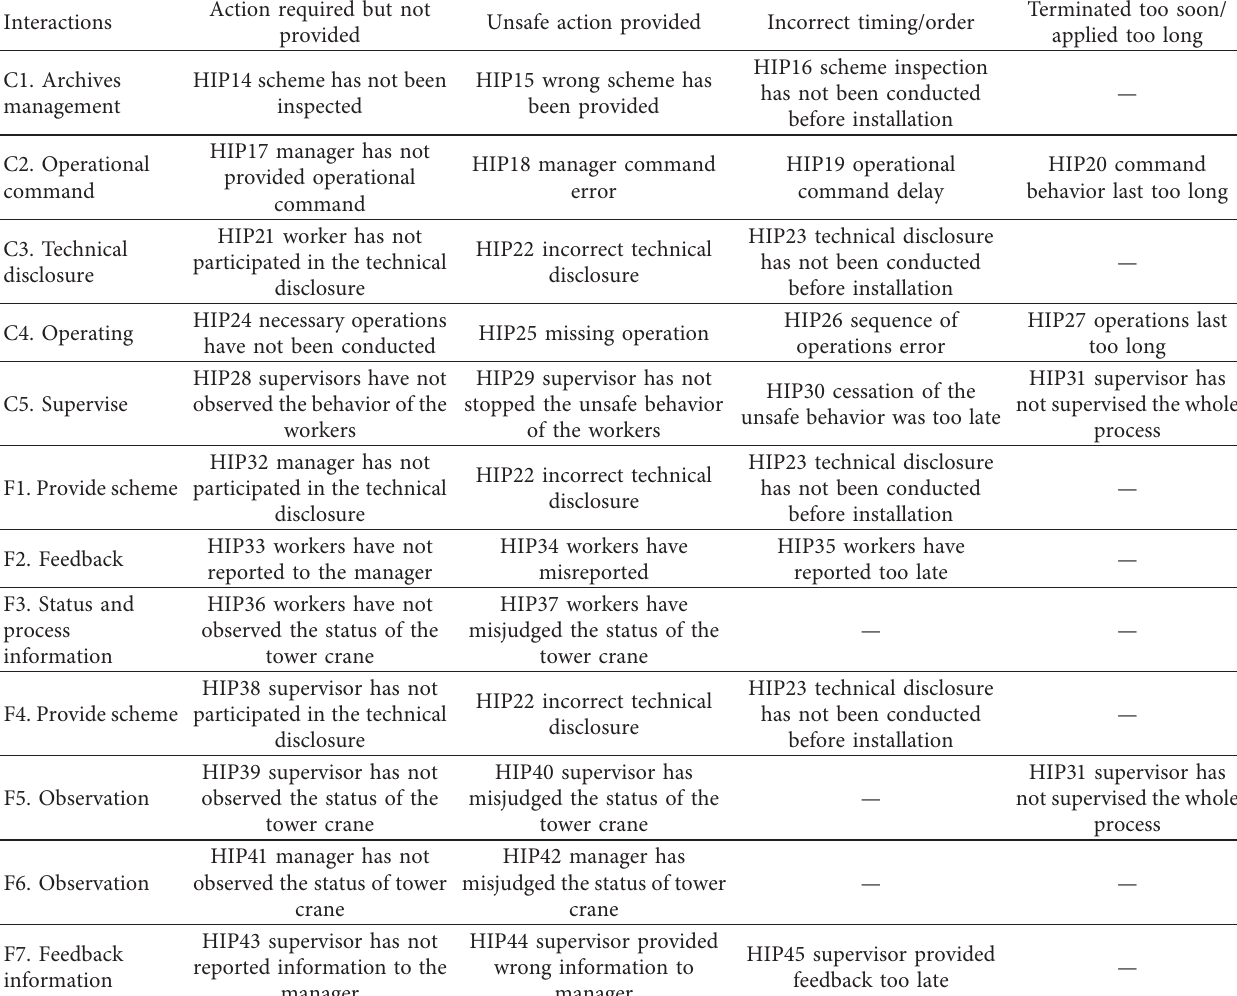
Table 5: Unsafe control action behaviors in the installation phase